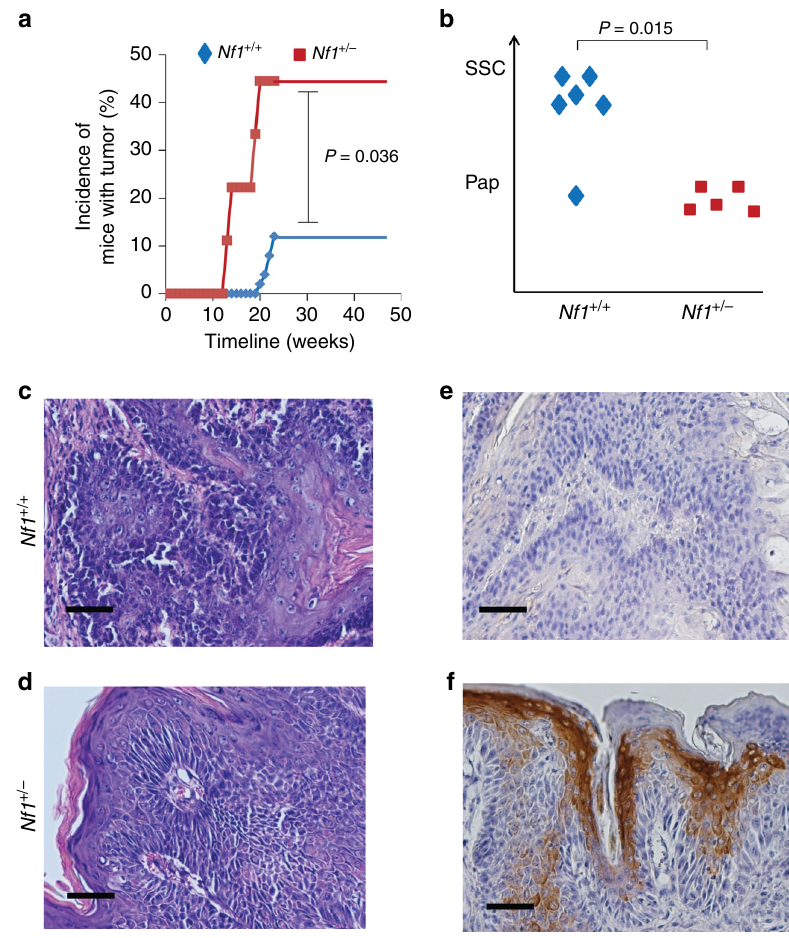
Fig. 3 Antagonistic role of Nf1 + / − microenvironment in DMBA/TPA-induced tumors. a Incidence of mice developing tumor under DMBA/TPA treatment as a function of time. A fraction of mice with Nf1 + / + (6 out of 50; 12%) and Nf1 + / − (4 out of 9; 44%) microenvironment developed at least one tumor (papilloma or SCC). Fischer exact test statistic was performed. b Tumors from six mice with Nf1 + / + and fi ve Nf1 + / − microenvironment were reviewed by a pathologist and classi fi ed as papilloma (benign) or SCC (malignant) based on c – f . Fischer exact test statistic was performed. Representative c, d H&E- stained and e, f IHC using K1 antibodies in histological sections of dissected DMBA/TPA-treated dorsal skin from c , e Nf1 + / + and d , f Nf1 + / − . Scale bar